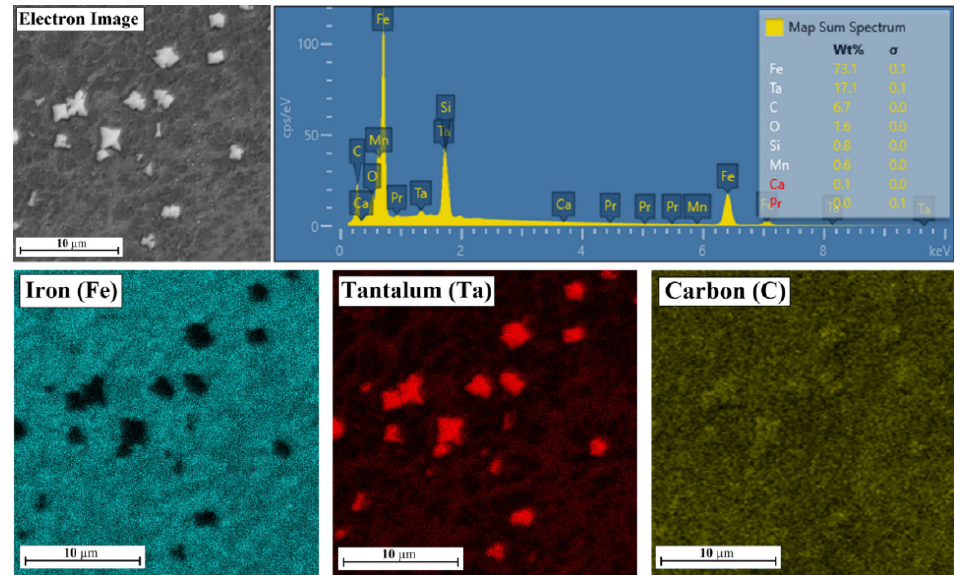
Figure 15. Chemical composition of middle area of the Fe/TaC coatings produced on tool steel using 90 µm thick pre-coat and laser beam power of 500 W.